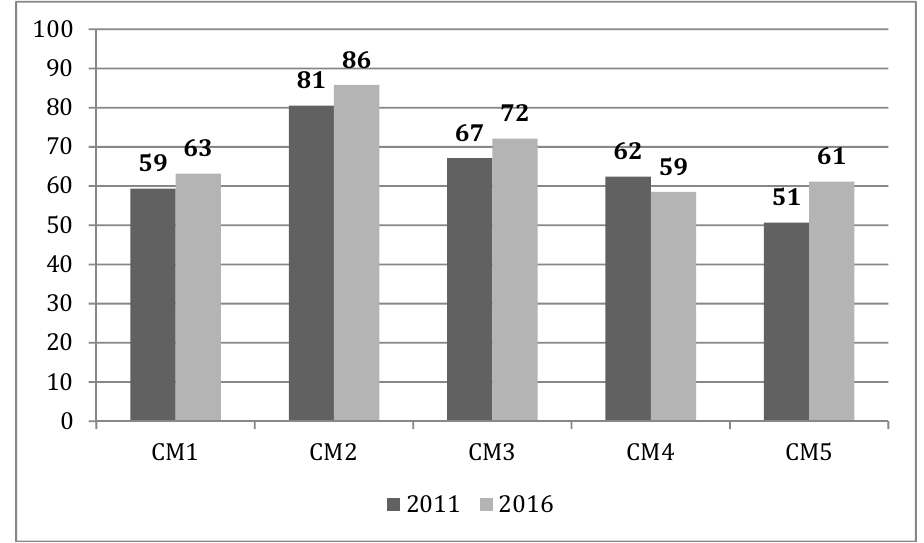
Figure 4. The results of the assessment of geological and mining criteria in 2011 and 2016 in the examined hard coal mines. Source: own work.